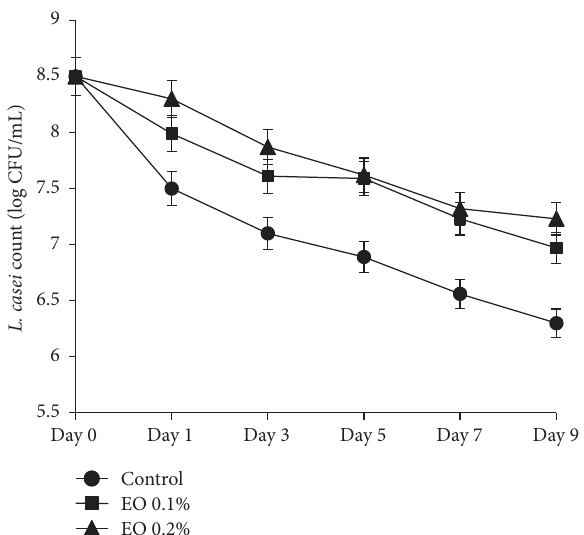
Figure 1: Viability of L. casei (log CFU/mL) at different concen- trations of Z. clinopodioides essential oil (0.1 and 0.2%) in Doogh samples during storage